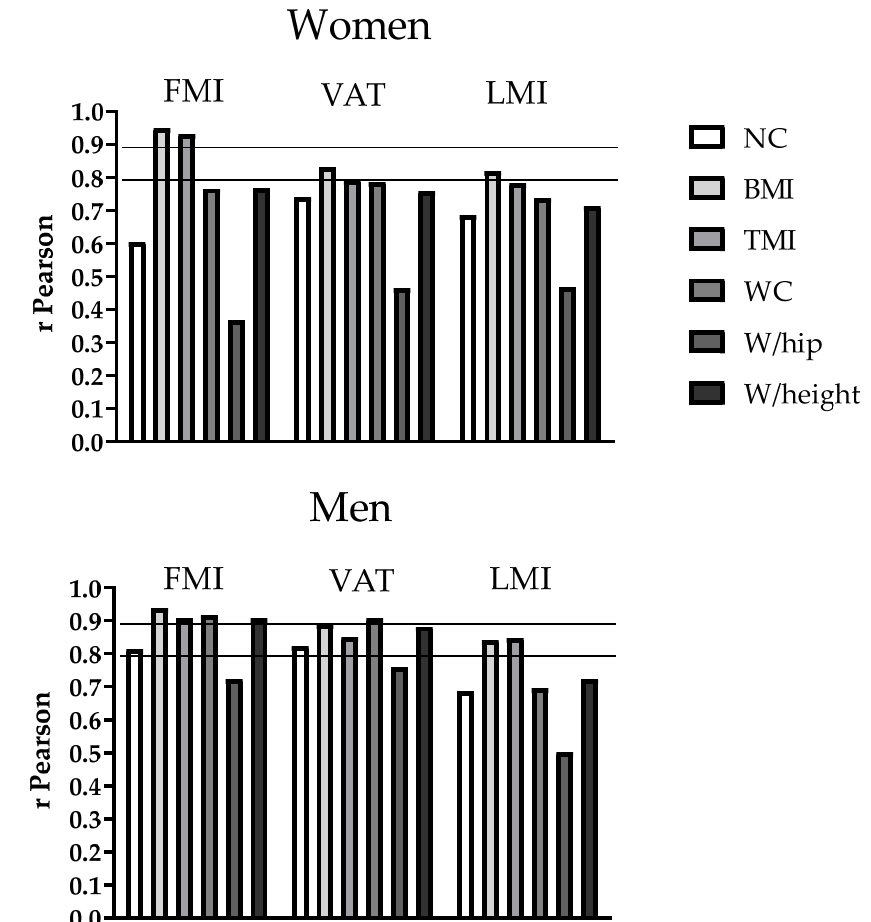
Figure 2. Association of anthropometric indicators with body composition measured by Dual X-ray absorptiometry (DXA) in women (n = 82) and men (n = 37). BMI: Body mass index; FMI: Fat mass index; LMI: Lean body mass index; NC: Neck circumference TMI: Triponderal mass index; VAT: Visceral adipose tissue; WC: Waist circumference; W / hip: Waist to hip ratio; W / height: Waist to height ratio.